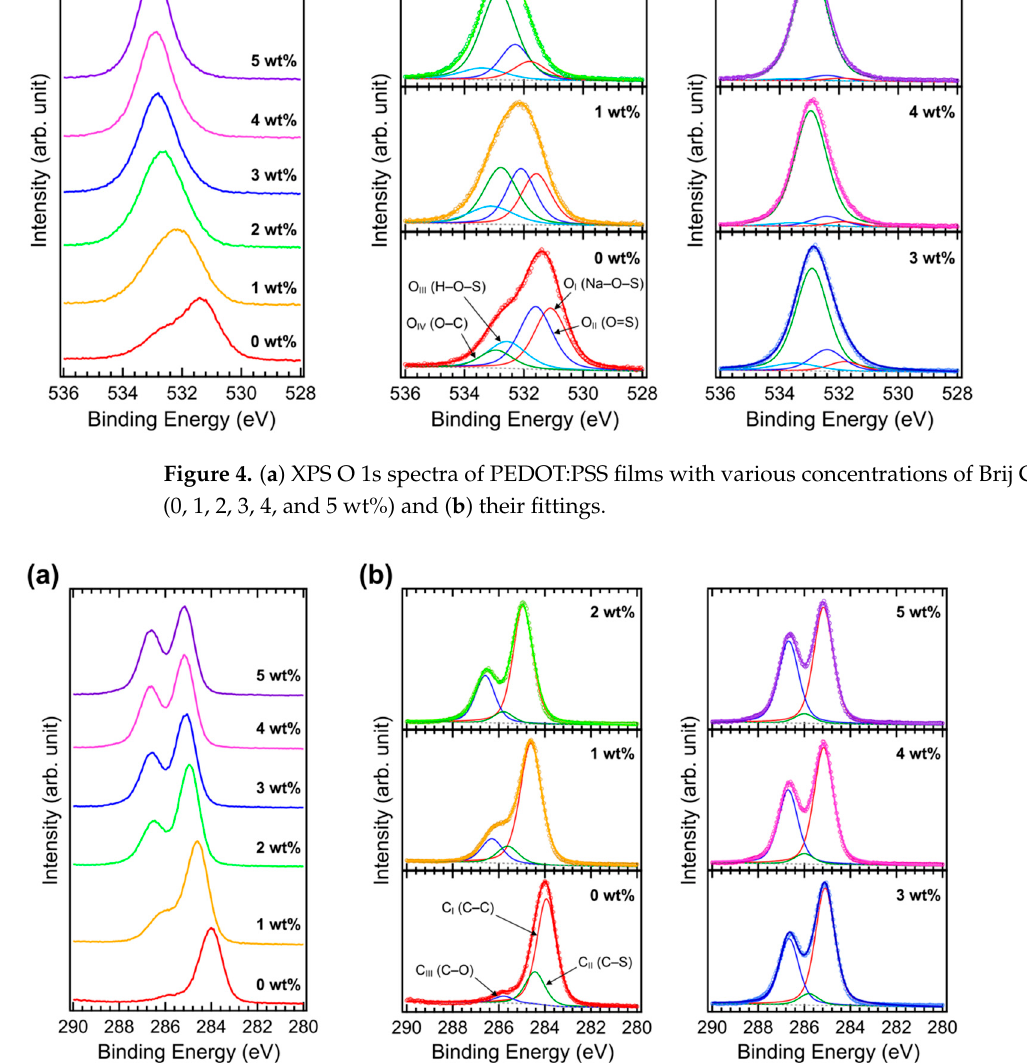
Figure 5. ( a ) XPS C 1s spectra of PEDOT:PSS films with various concentrations of Brij C10 additive (0, 1, 2, 3, 4, and 5 wt%) and ( b ) their fittings.